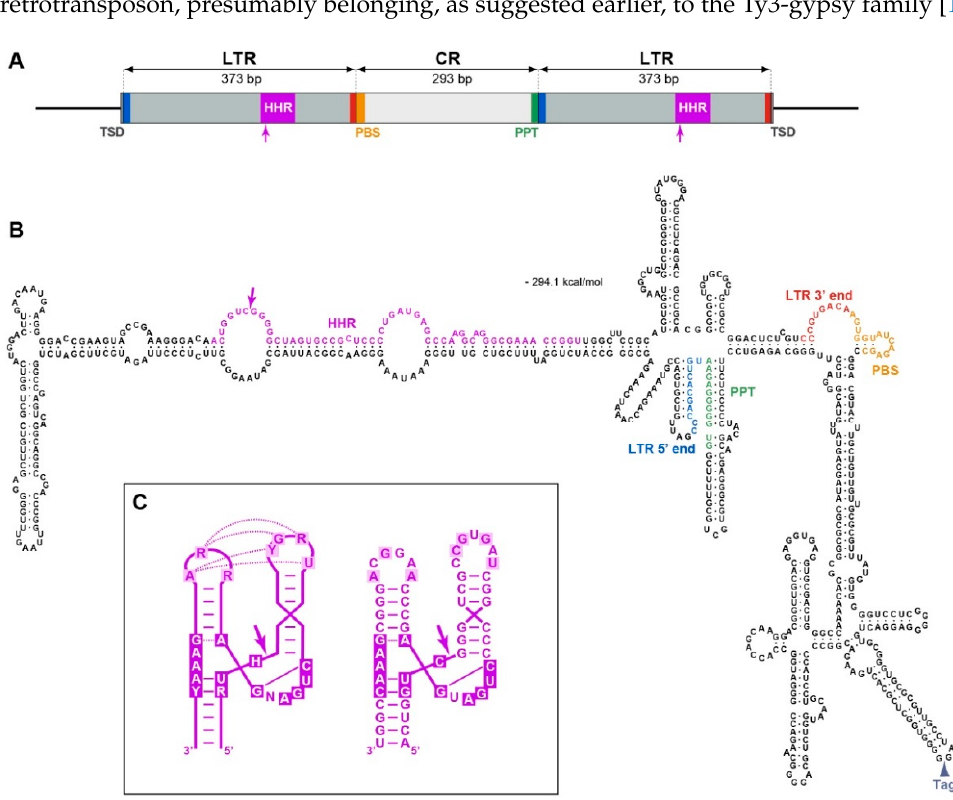
Figure 1. Structure of NbRZ1. ( A ) Schematic representation of the NbRZ1 genomic locus. The box indicates the NbRZ1 sequence, and flanking genomic regions are shown by lines. Lengths of LTRs and the CR are indicated. The position of the hammerhead ribozyme is shown in magenta, and the arrow points to the site of autocatalytic cleavage. PBS and PPT sequences are shown in yellow and green, respectively. ( B ) Predicted secondary structure of circular NbRZ1 RNA. Key structural elements are marked with the same colors as in ( A ). The arrowhead points to the site of tag insertion in the construct NbRZ1-Tag. Terminal LTR sequences are marked with blue and red in both ( A ) and ( B ) to facilitate their localization in the NbRZ1 secondary structure model. ( C ) Structural model of the NbRZ1 ribozyme. Left, base-pairing and key residues typical for Type III ribozymes. Residues forming the catalytic center are shown in white in magenta boxes, and dotted lines show noncanonical interactions in the ribozyme tertiary structure. Right, NbRZ1 ribozyme showing all essential features of Type III